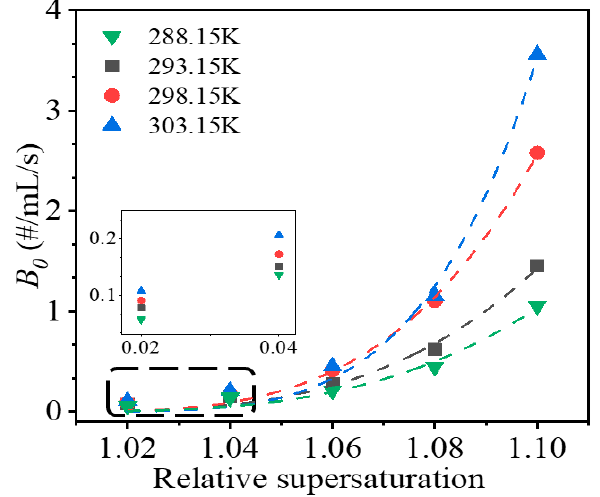
Figure 4. Secondary nucleation rates of AIBN at different supersaturation levels and temperatures.